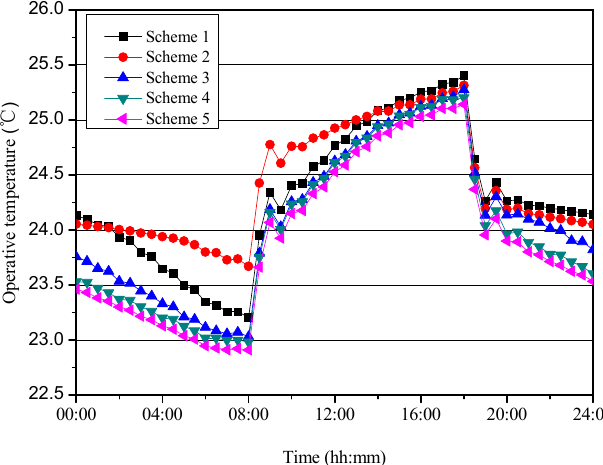
Figure 16. Operative temperature variation trends of different cooling time distribution schemes on 10 July.